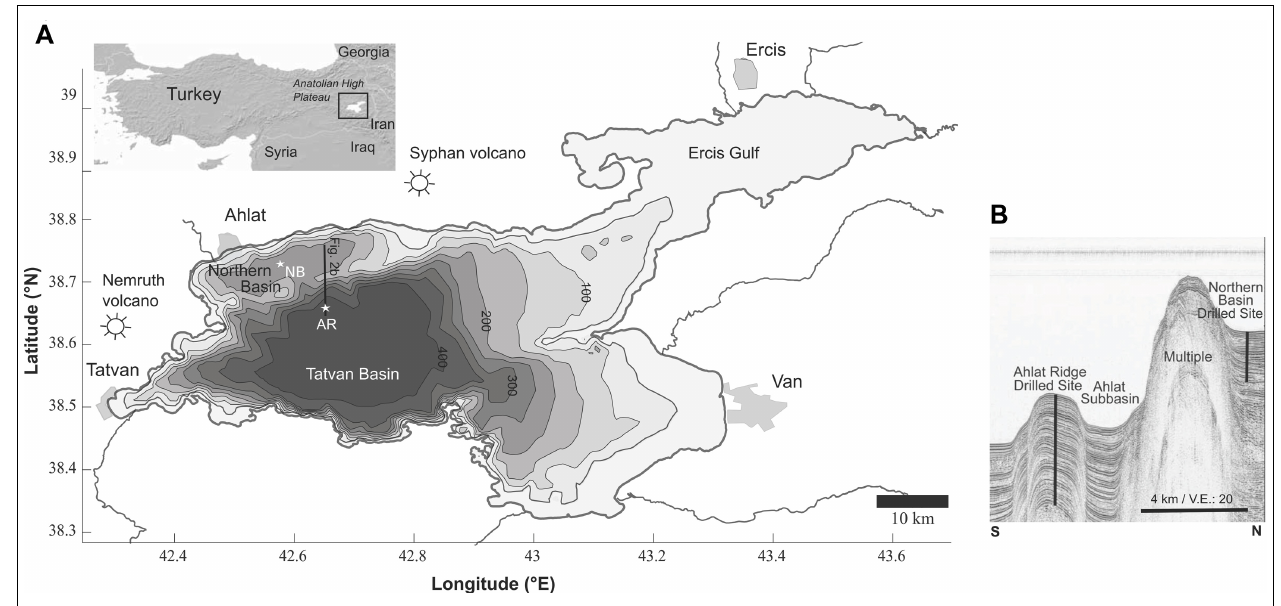
FIGURE 1 | (A) Bathymetric map of LakeVan, showing the major basins, volcanoes and cities.The two drill sites are marked with stars (AR, Ahlat Ridge; NB, Northern Basin). (B) Seismic profile along a N–S transect, showing the basins and ridges. Note: the NB drill site is west of the seismic line is a projection and draw here for comparison. Modified from Litt etal.